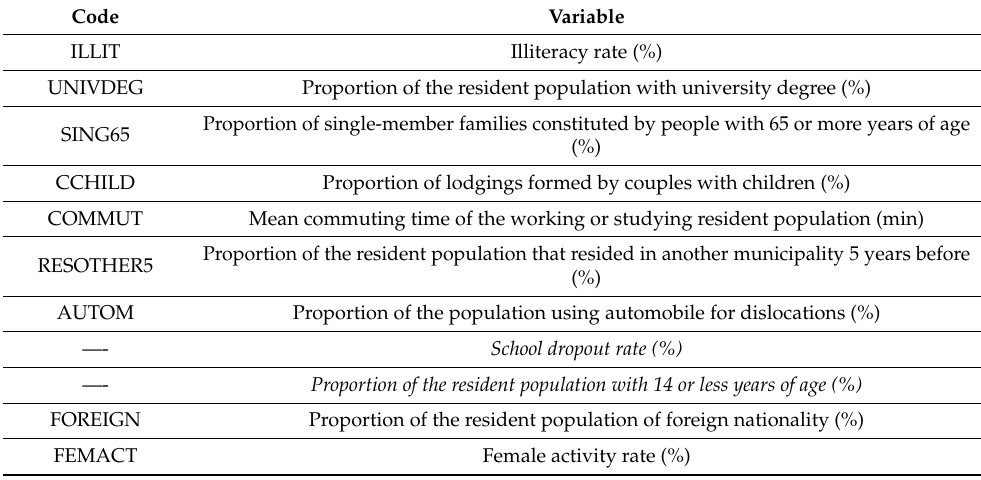
Table 2. The set of 25 variables used as input in the PCA for defining criticality. All variables are at the parish scale and were extracted from the 2011 census, published by Statistics Portugal. Variables in italic were not selected for the extracted principal